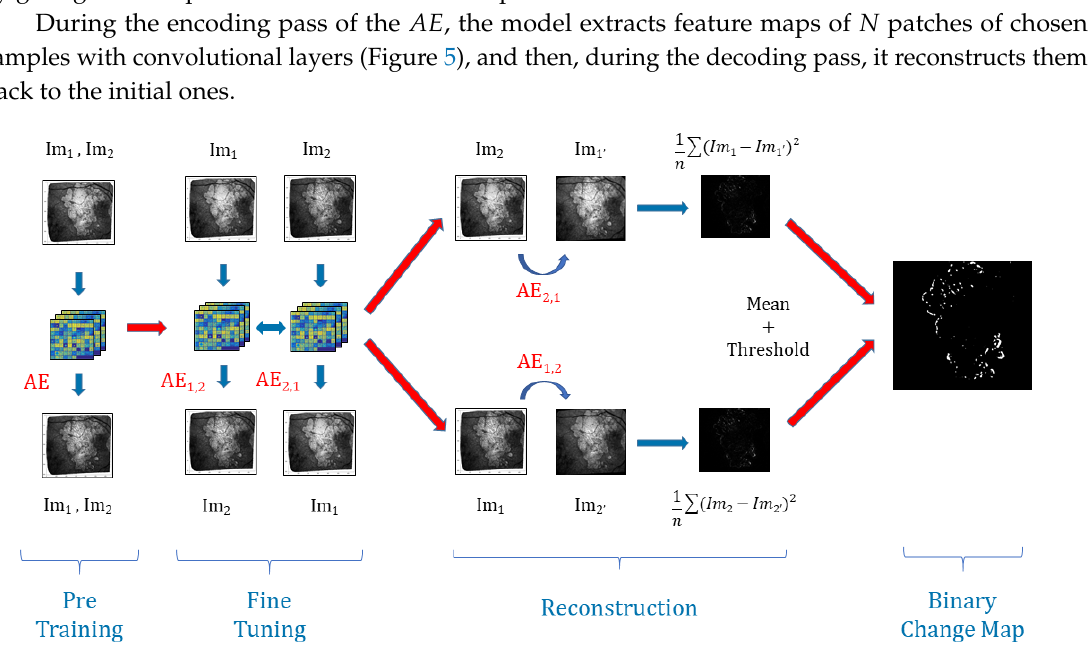
Figure 5. Structure of the algorithm. Example for set of two images Im 1 and Im 2 and n the number of